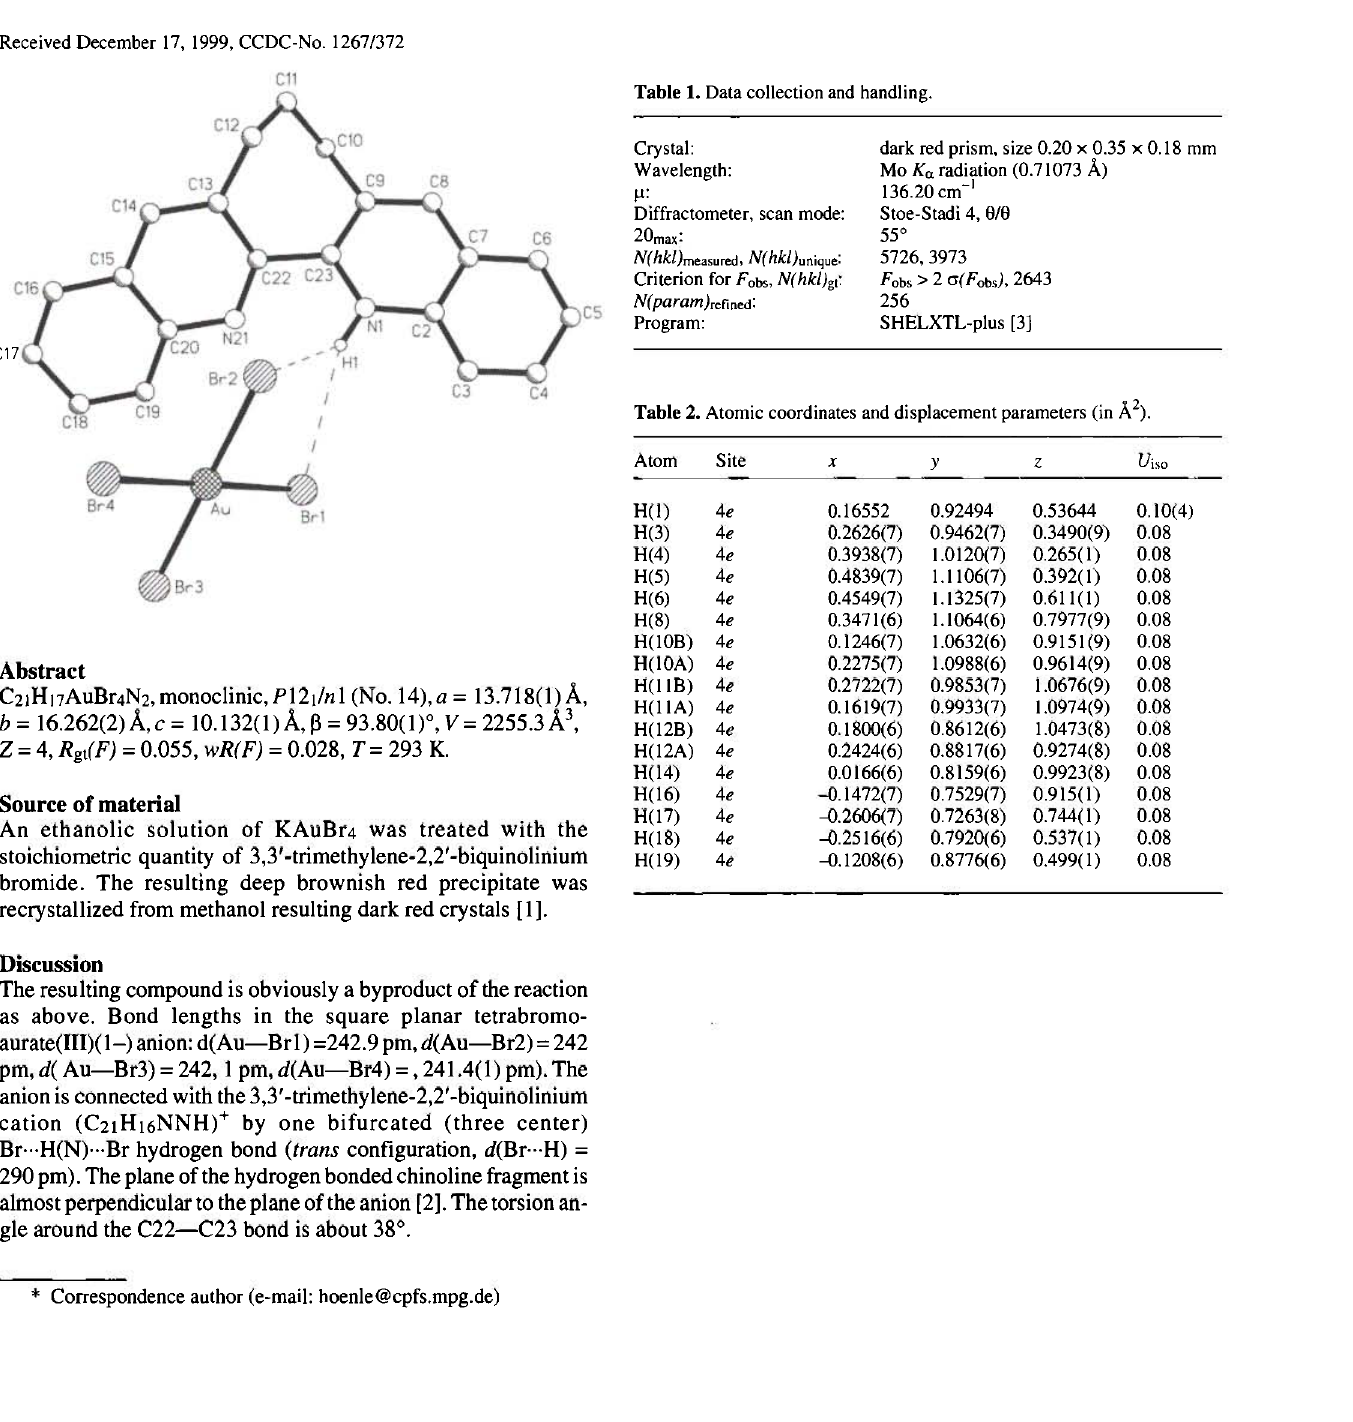
Table 1. Data collection and handling.